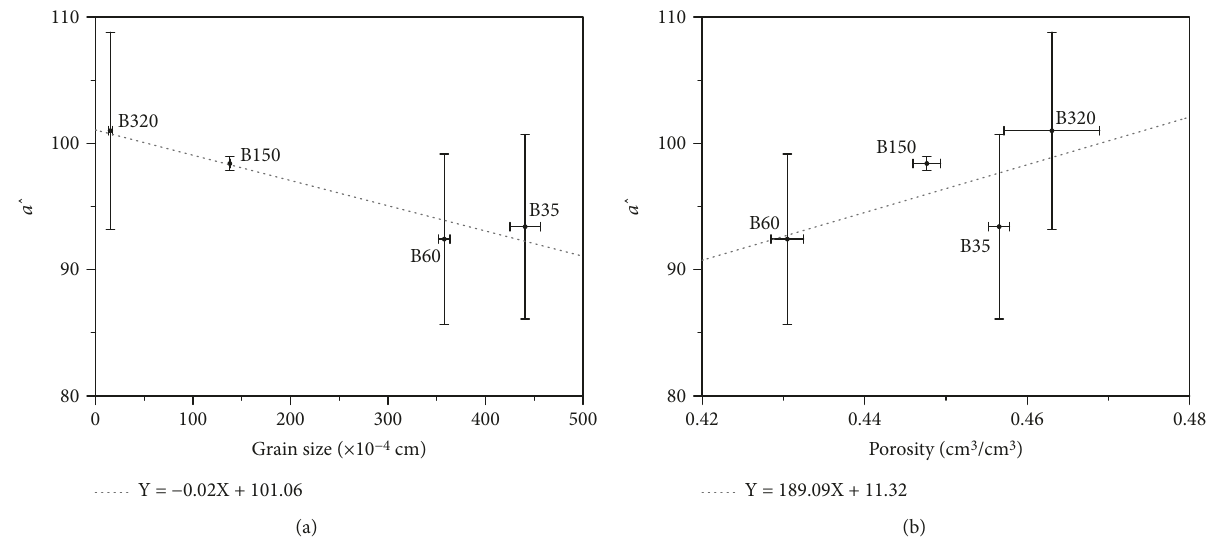
Figure 8: MGAM parameter α versus (a) grain size and (b) porosity.